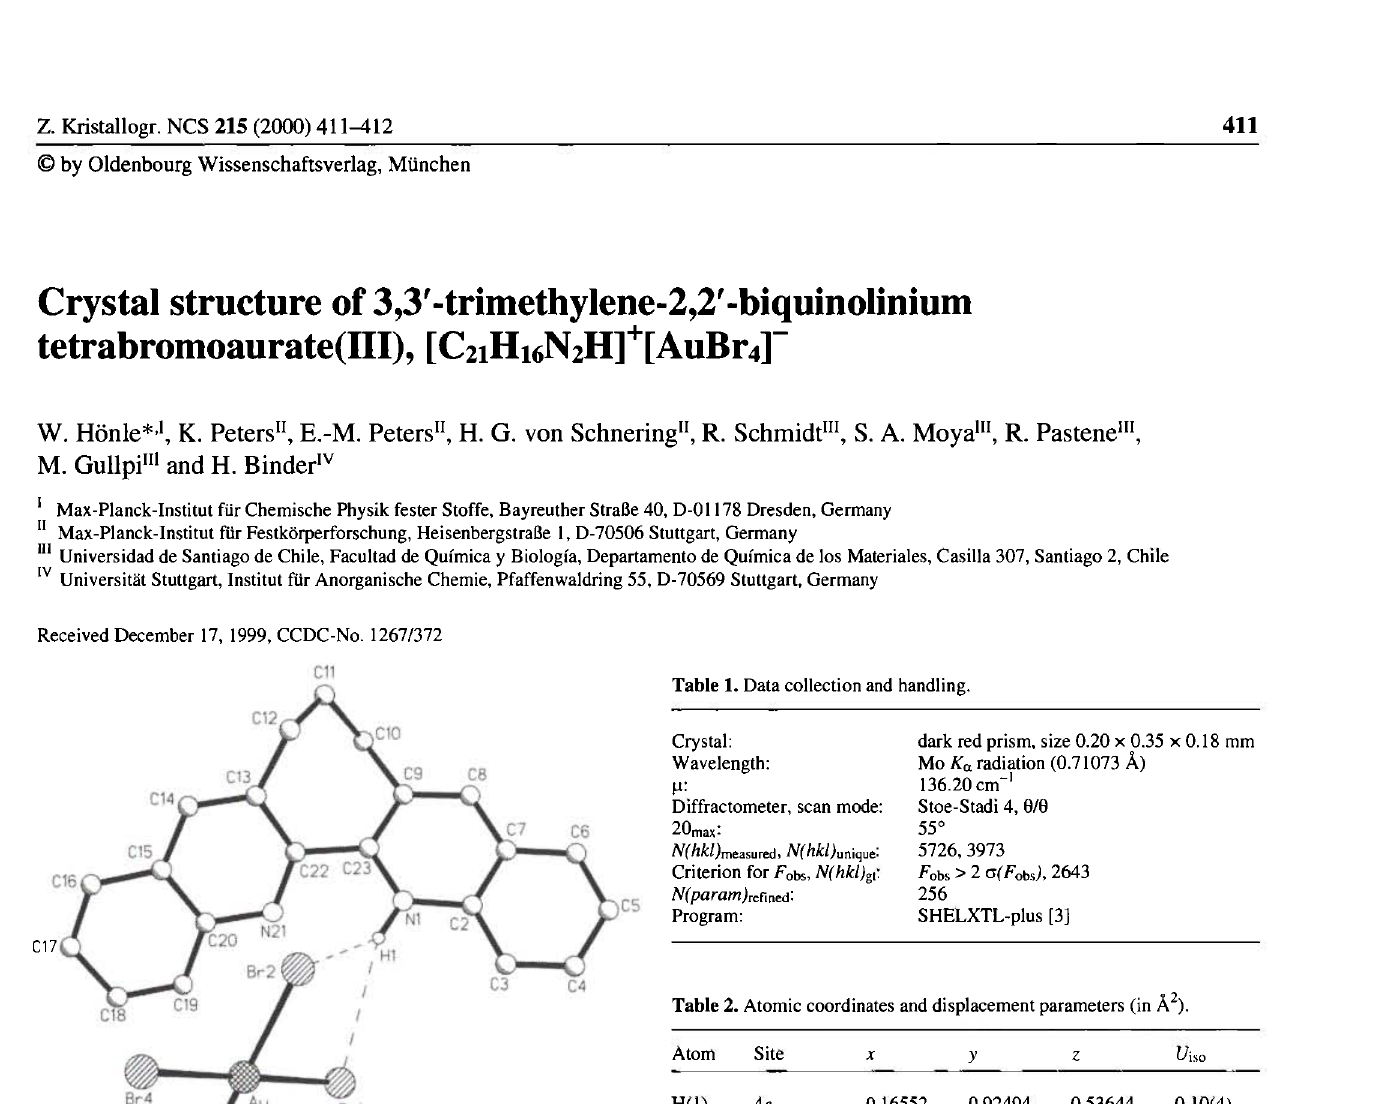
Table 2. Atomic coordinates and displacement parameters (in A 2